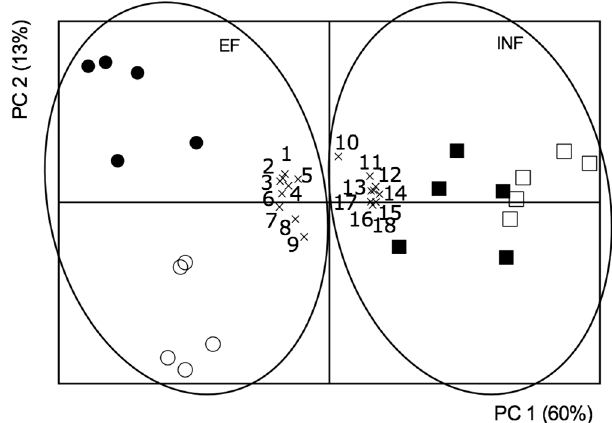
Figure 10. Biplot of score and loading factors of the principal component analysis (PCA). E ffi cient (circles) and ine ffi cient (squares) soybean lines, grown under Fe su ffi ciency ( + Fe, 20 µ M; solid symbols) or Fe deficiency ( − Fe, no Fe; open symbols) for 14 days under hydroponic conditions and associated factors: 1—anthocyanin concentration; 2—total chlorophyll concentration; 3—carotenoid concentration; 4—leaf ∂ -aminolevulinic acid concentration; 5—leaf MDA concentration; 6—leaf ascorbate peroxidase activity; 7—root ascorbate peroxidase activity; 8—root glutathione reductase concentration; 12—root hemin concentration; 13—leaf catalase activity; 14—root catalase activity; 15—leaf glutathione reductase activity; 16—root MDA concentration; 17—leaf SOD activity; 18—root SOD activity.